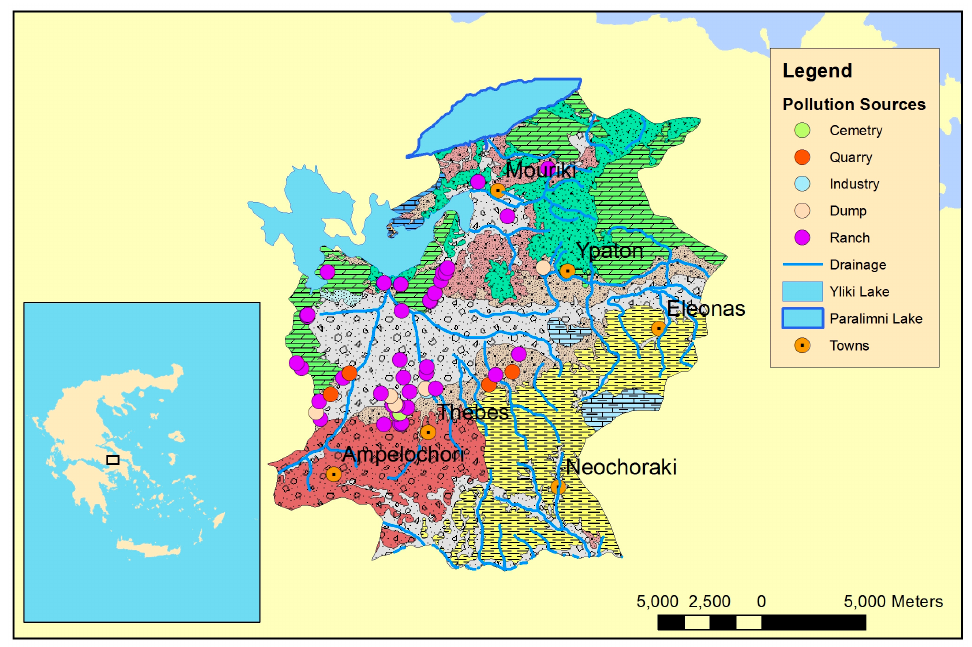
Figure 3. Sources of anthropogenic pollution according to the Institute of Geological and Mineralogical Research (IGME) 2010.